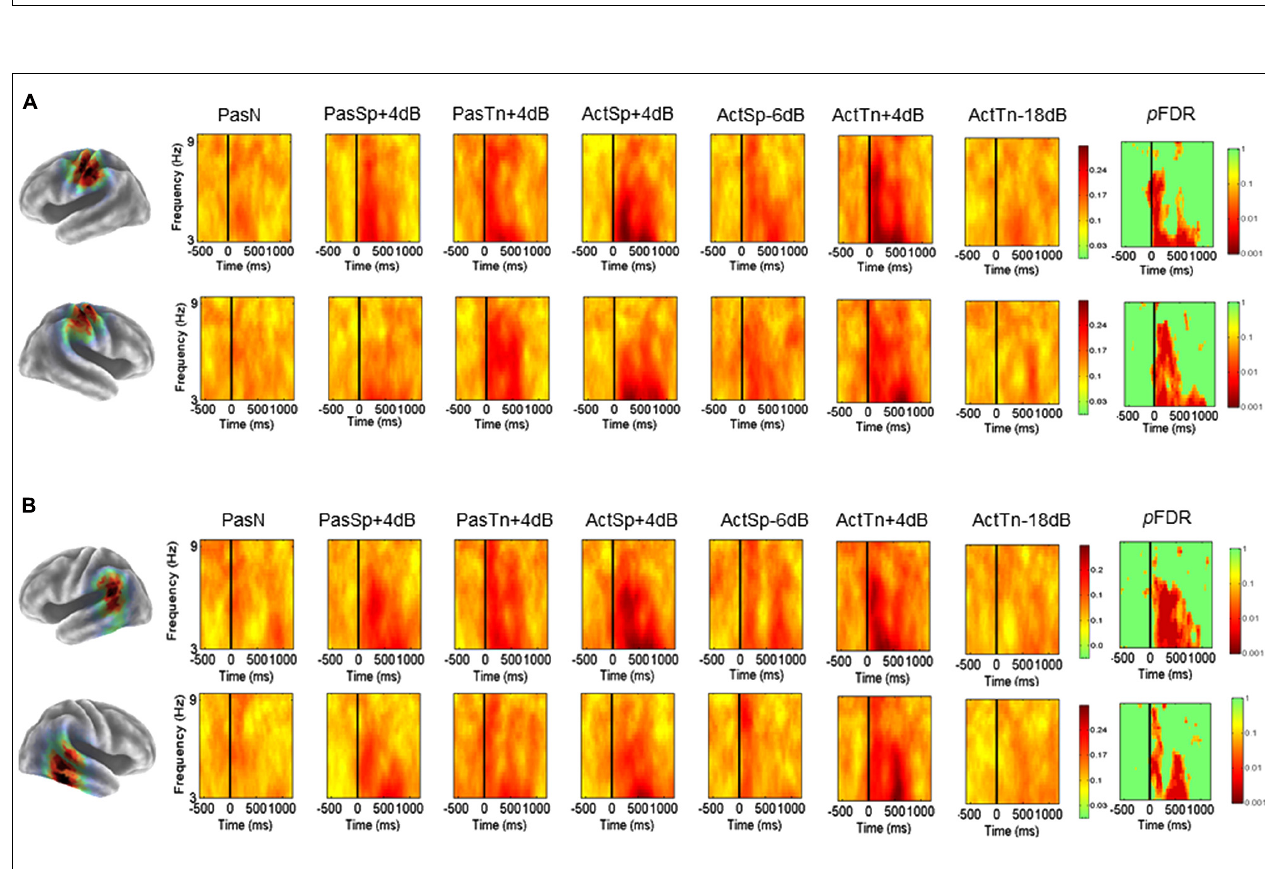
FIGURE 5 | Mean left and right hemisphere sensorimotor ( μ ) and temporal ( α ) ITCs. (A) Mean ITCs for the left and right sensorimotor component clusters as a function of condition with p -values corrected for false discovery rate in a separate map (non-significant values indicated in